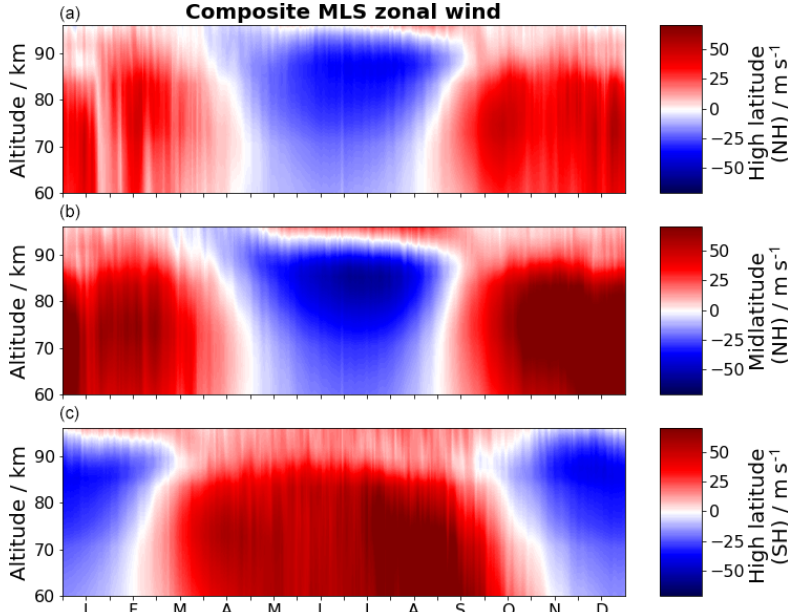
Figure 3. Composite of zonal wind for the high-latitude location (a) and midlatitude location (b) . The composite of both figures includes 12 years of wind data derived from MLS geopotential height data. Positive values corresponds to eastward-directed winds and negative to westward-directed winds. The altitude is given in geopotential